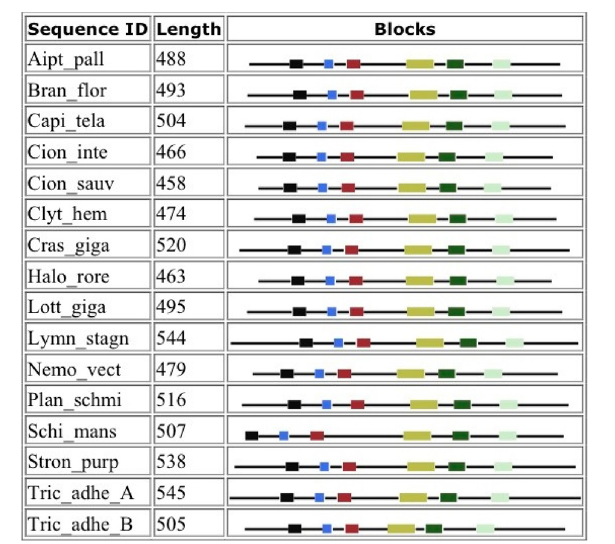
FIGURE 4 | Blocks generated from the UrBACE sequences. The six conserved regions are shown in N-terminal to C-terminal